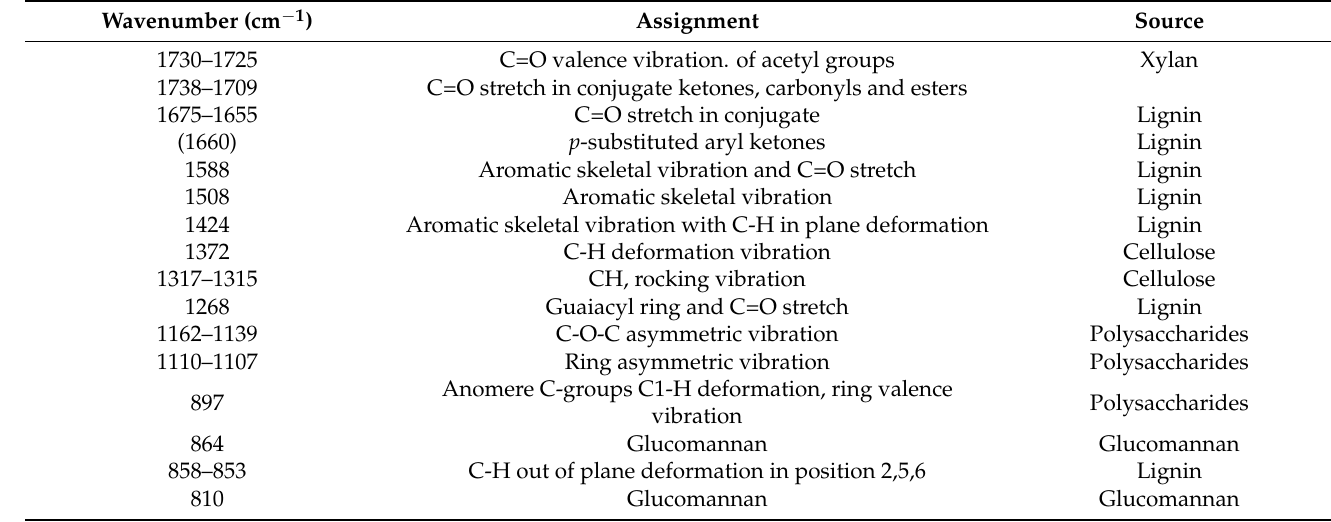
Table 3. Assignments of infrared bands in spruce ( Picea abies (L.) Karst.) [16].